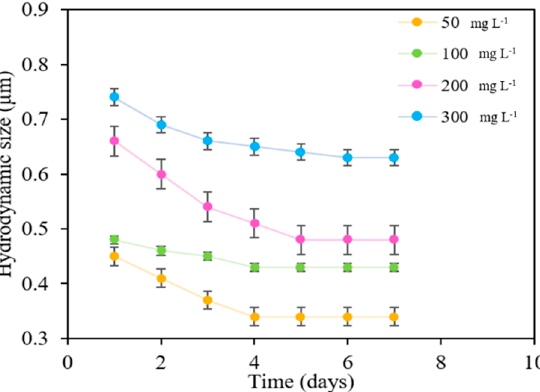
Figure 1. Change in hydrodynamic size (d50) for 7 days for emulsions prepared at different crude oil concentrations between 50 and 300 mg L − 1 .